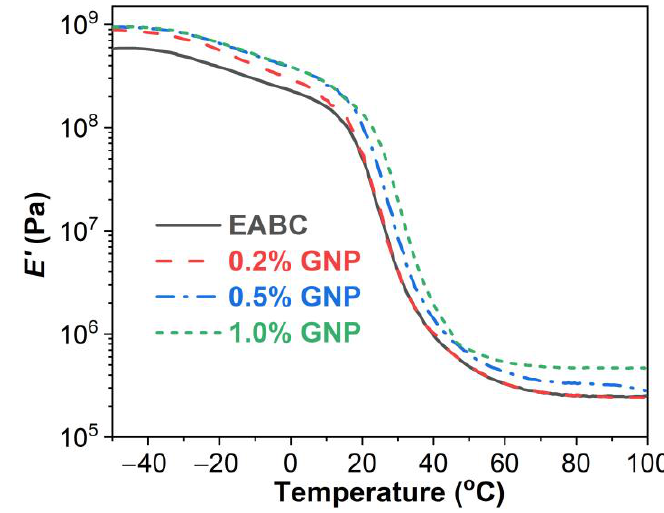
Figure 6. E ′ as a function of temperature of GNP-reinforced EABCs.